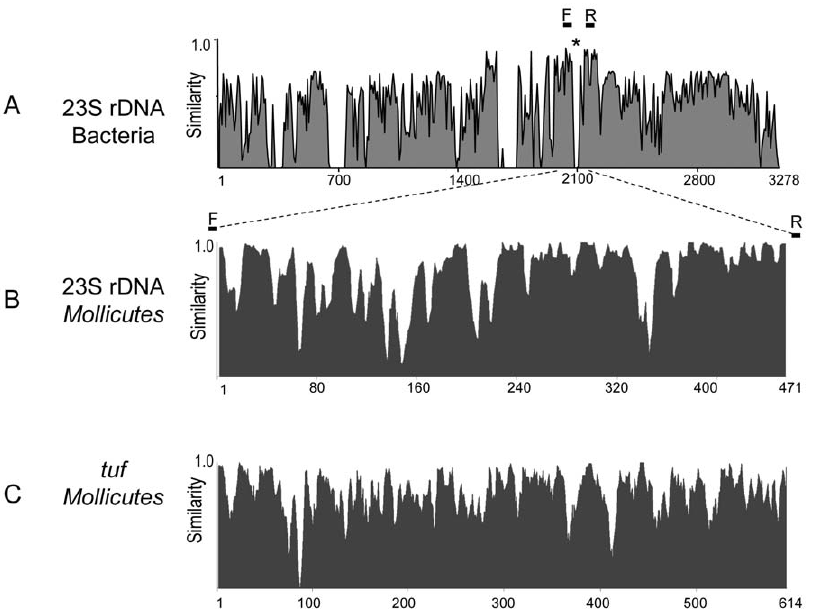
Figure 1. Sequence similarity plots of the target regions used in the present microarray. Numbers on the abscissa denote positions in the sequence alignment. The diagrams were produced using Vector NTI 11 and are based on alignments of A) complete 23S rRNA genes of 10 selected eubacterial species and 9 mycoplasmas (asterisk showing the location of the 23–26-nt deletion found in all Mollicutes spp.), B) the 471-nt signature region of all 44 mycoplasmas included in this study (alignment in File S2), and C) the central 614-nt region of the tuf gene of 43 mycoplasma species (alignment in File S3). Bars denoted F and R indicate the positions of forward and reverse primers, respectively, that were used for amplification. MVW 1–3 indicate the positions of most variable windows.